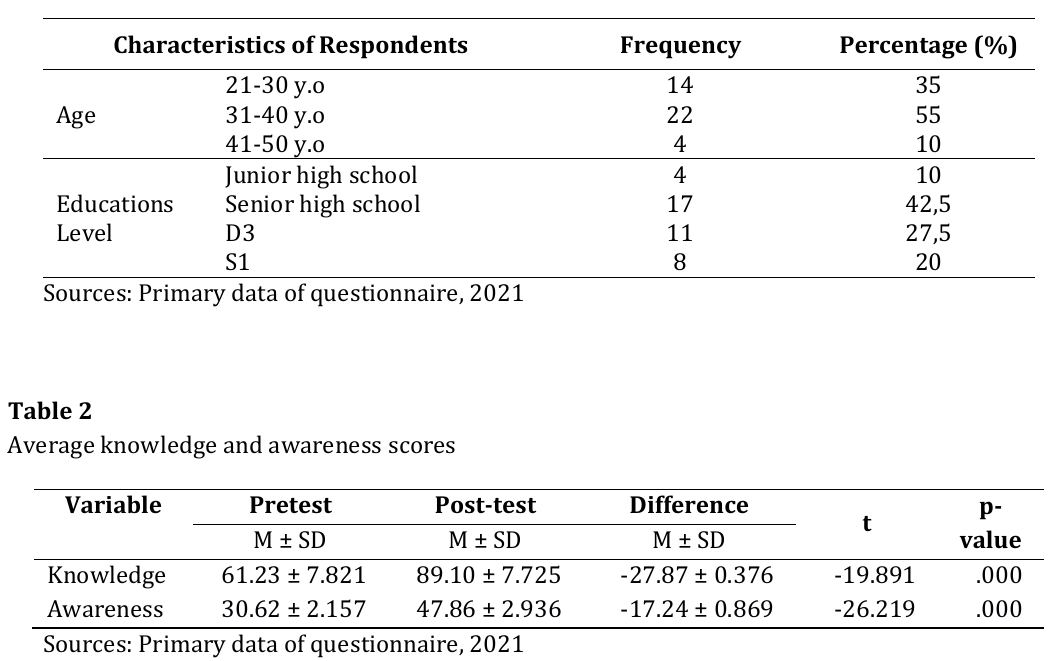
Characteristics of respondents